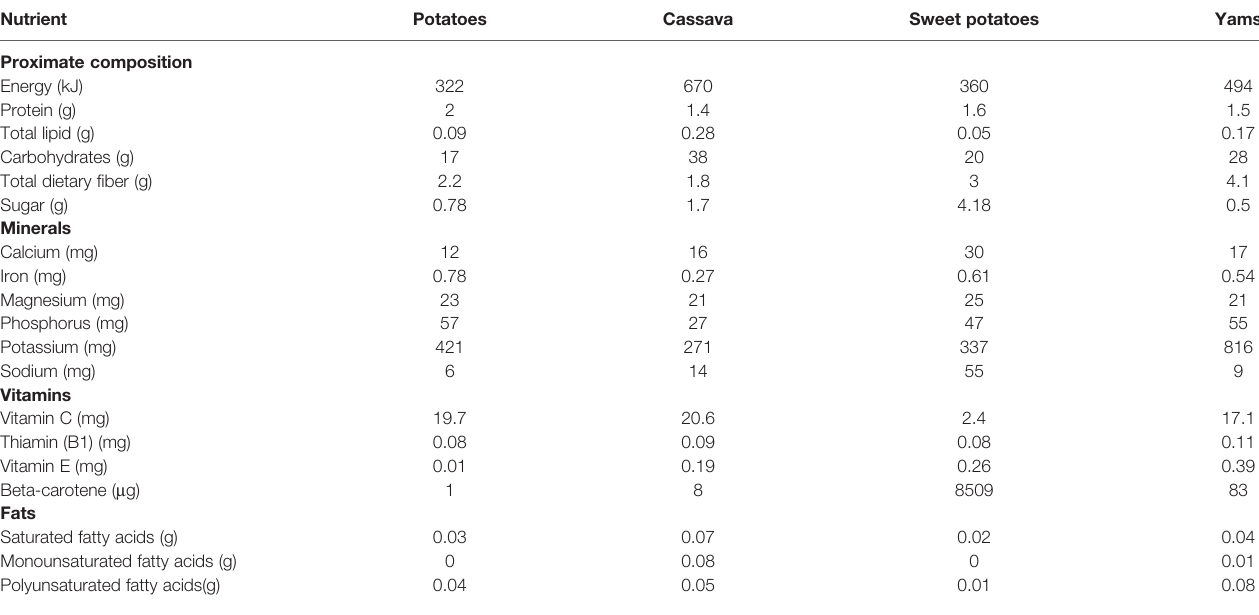
TABLE 2 | Comparison of nutritional composition of selected crops with yam (USDA, 2015; Chandrasekara and Kumar, 2016).